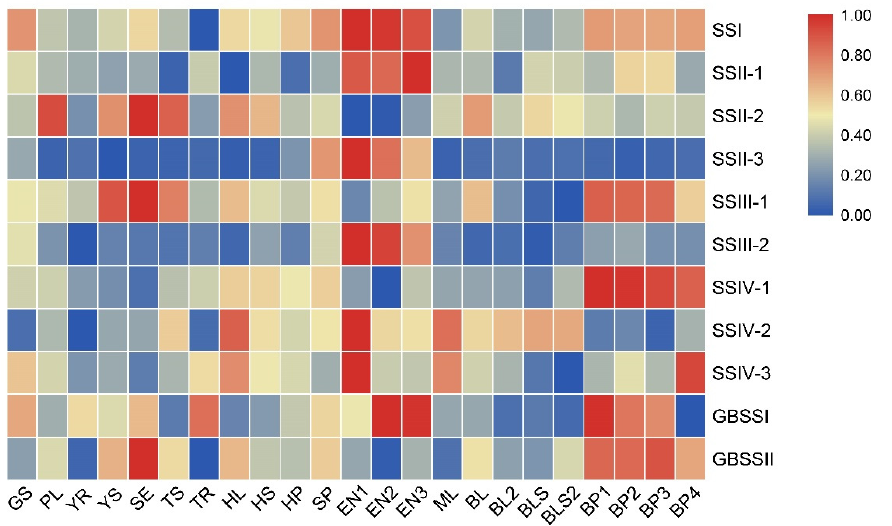
Figure 5. Expression profiles of OsSS genes in diverse tissues and across different stages. Expression Data (FPKM) standardization in each line and re-count relative expression from 0 to 1 was performed. GS: germinating seed; PL: plumule; YR: radicle; YS: young seedling; SE: seedling at trefoil stage; TS: shoot under 2 tillers; TR: root under 2 tillers; HL: flag leaf in heading date; HS: stem in heading stage; HP: panicle in heading stage; SP: spikelet; EN1: endosperm seven days after pollination; EN2: endosperm 14 days after pollination; EN3: endosperm 21 days after pollination; ML: flag leaf in mature stage; BL: mature leaf blade under young panicle; BL2: mature leaf blade under mature panicle; BLS: mature leaf sheath under young panicle; BLS2: mature leaf sheath under mature panicle; BP1: developing panicle (length < 1 mm); BP2: developing panicle (3 mm < length < 5 mm); BP3: developing panicle (10 mm < length < 15 mm); BP4: developing panicle (40 mm < length < 50